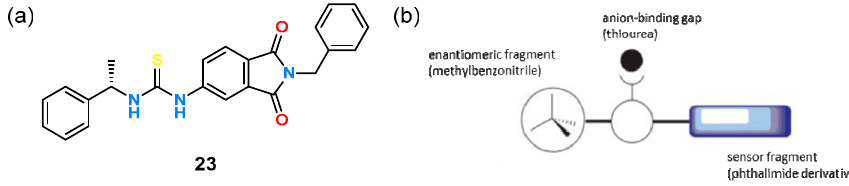
Figure 9. ( a ) The structure of receptor 23 and ( b ) its mode of operation as a